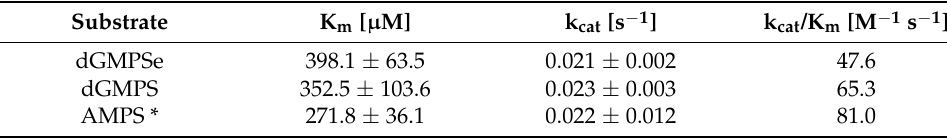
Figure 3. The profile of the nonlinear regression Michaelis–Menten fit of the HINT1-assisted hy- drolysis of dGMPSe and dGMPS. Reactions were performed at different substrate concentrations in triplicate. Error bars represent ± SEM.